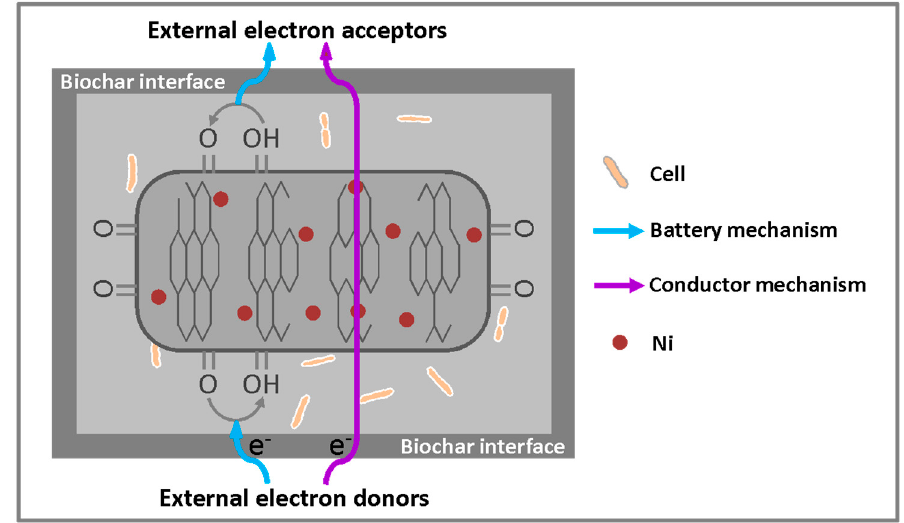
Figure 2. Schematic diagram of the biochar-internal pathways for electron transfer mediated by